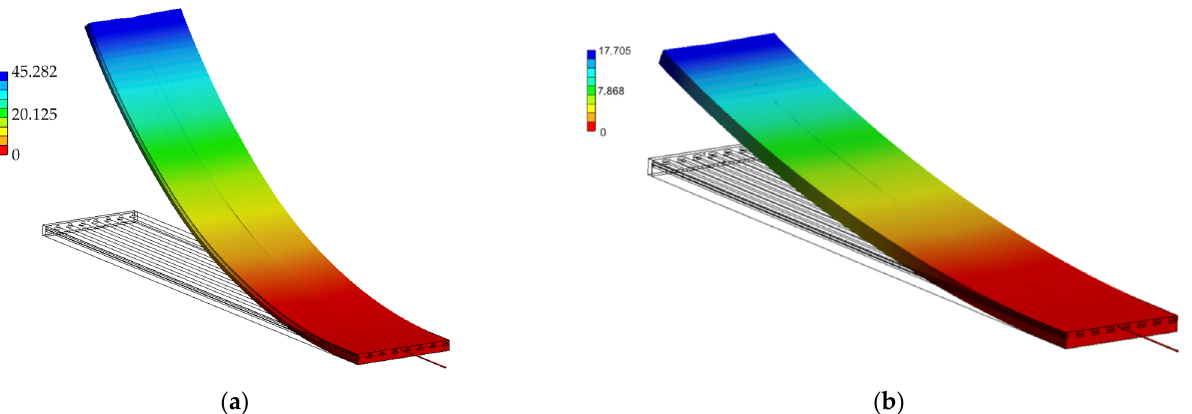
Figure 17. Simulation results of ( a ) Var1 and ( b ) Var2. The color coding denotes the vertical deformation.